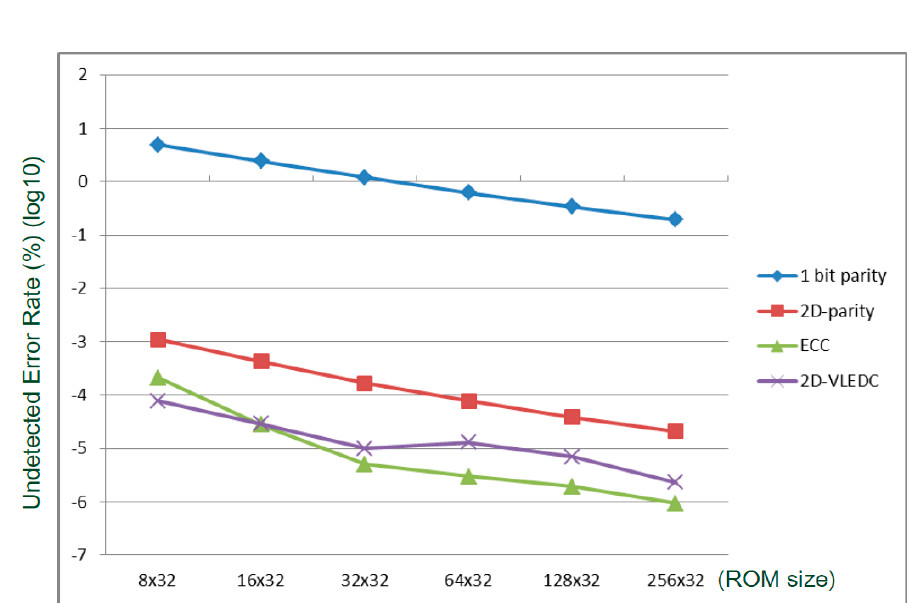
Figure 8. The comparison of error coverage performance.